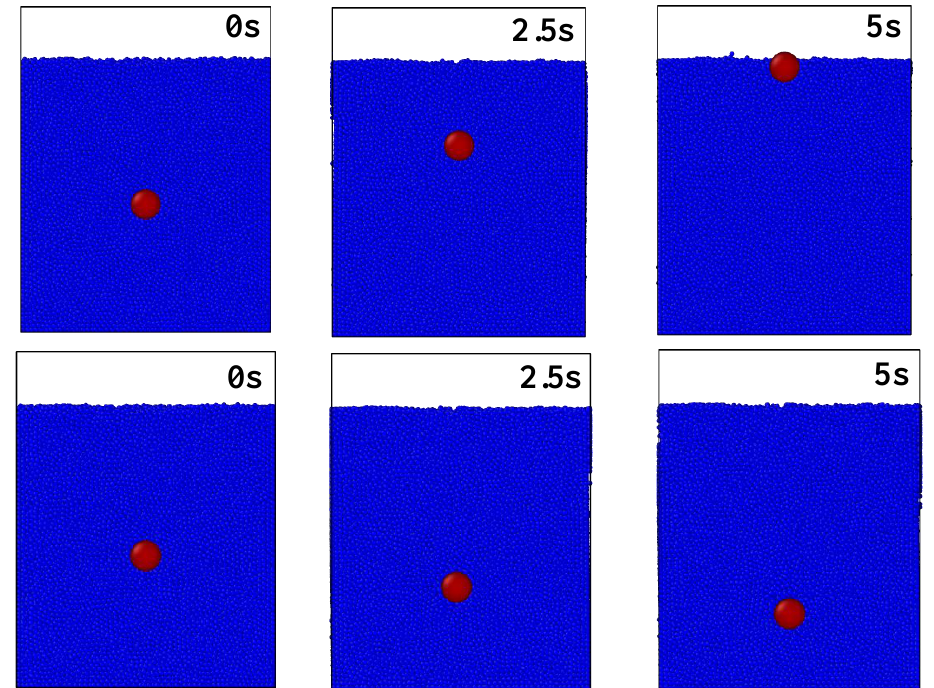
Figure 5. Snapshots during the rising and sinking processes. Only the relevant part of the system is shown. Top: the initial, intermediate and final positions of the SO, for Ω = − 80 rad/s, A = 0.03 m, and f = 3 Hz. The relevant simulation ended when the SO broke the top surface of the granular bed. Bottom: the initial, intermediate and final position of the SO, for Ω = 80 rad/s, A = 0.03 m and f = 3 Hz. The SO settles at about z = − 0.3 m due to the interaction with the bottom